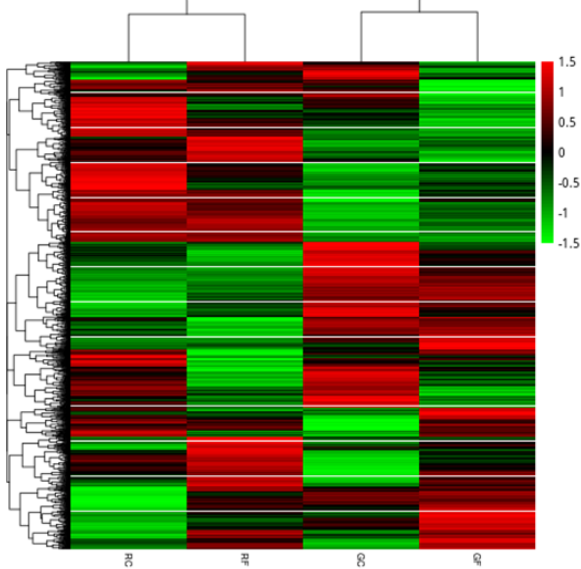
Figure 7. Differentially expressed gene clustering heat map; the abscissa in the figure is the clustering results and the names of samples, the ordinate is the clustering results of differential genes, and the color represents the expression level of the gene in the sample. The redder the color, the higher the expression, and the greener the color, the lower the expression.